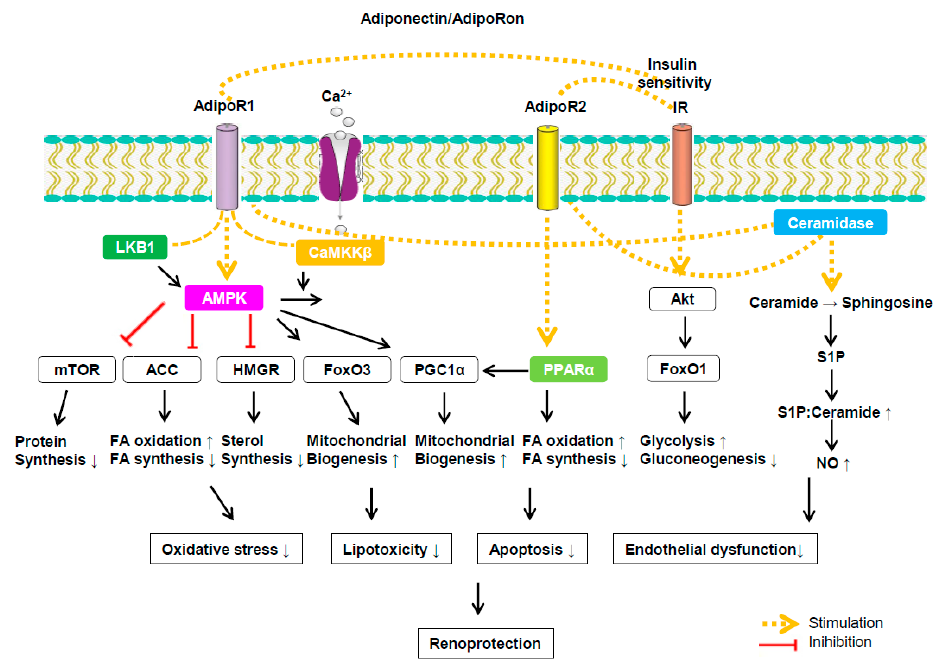
Figure 1. Signaling pathways associated with adiponectin and its receptor binding. AdipoR1 increases calcium influx to activate Ca 2+ /calmodulin-dependent protein kinase kinase β (CaMKK β ) and subsequent downstream kinases. AdipoR1 also activates liver kinase B1 (LKB1) and AMPK that can increase peroxisome proliferator-activated receptor (PPAR) gamma coactivator 1 alpha (PGC-1) expression. Activation of associated downstream pathways exert prometabolic effects by enhancing fatty acid oxidation and mitochondrial biogenesis. AdipoR2 activate PPAR α to increase fatty acid oxidation and insulin sensitivity. AdipopR1/2 has ceramidase activity and can catalyze the conversion of ceramide to sphingosine, which produces sphingosine-1-phosphate (S1P), subsequently increasing S1P to ceramide ratio that further ameliorates endothelial dysfunction